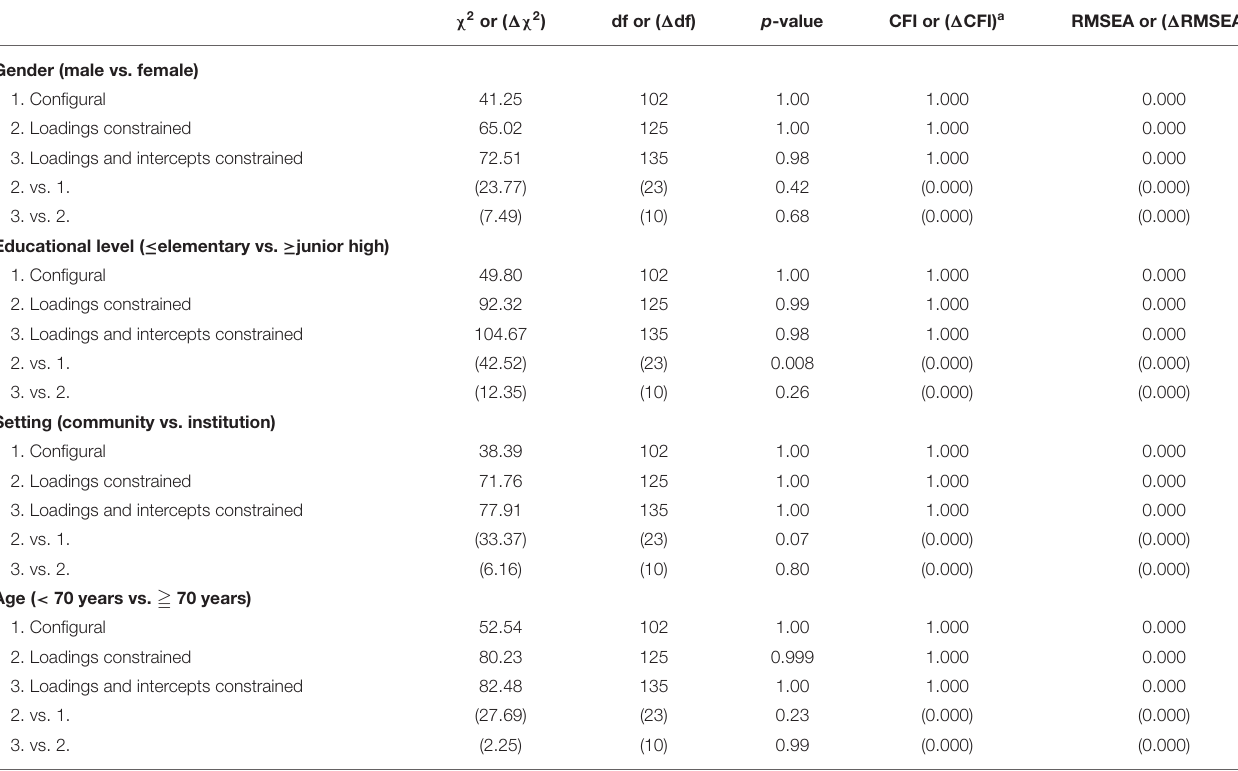
TABLE 3 | Measurement invariance of bifactor model across gender, educational level, and setting using entire sample. χ 2 or ( 1 χ 2 )